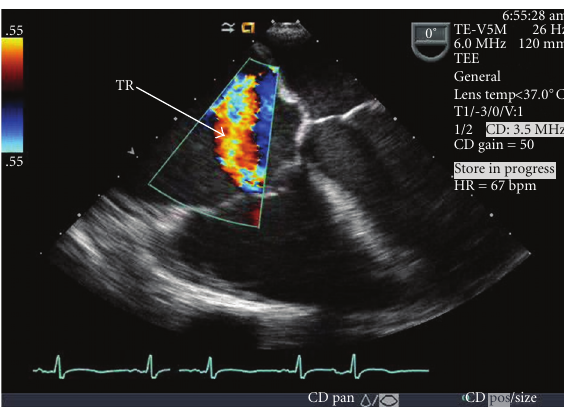
Figure 1: TEE showing severe tricuspid regurgitation.